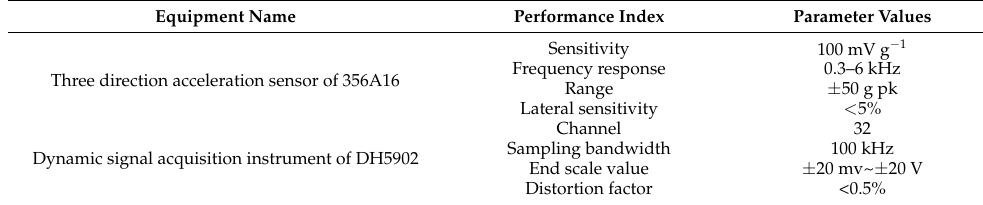
Table 3. Performance parameters of vibration test instruments.